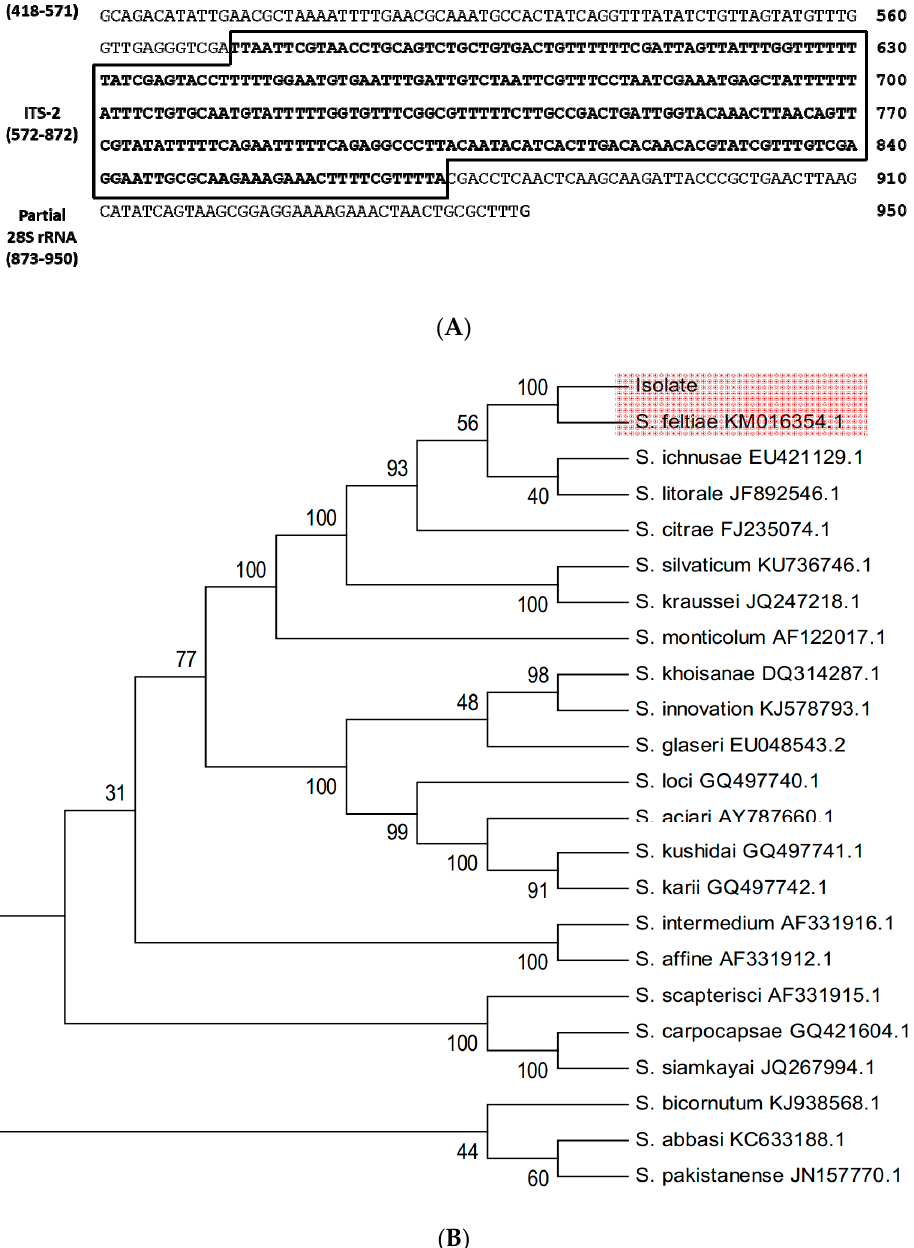
Figure 2. Molecular identification of S. feltiae isolate. ( A ) Sequence analysis of ITS / rRNA region of the nematode isolate. Two ITS regions are marked with boxes. The DNA sequence was deposited to GenBank with an accession number of MN093395.1. ( B ) Phylogenetic relationship of the nematode isolate with other Steinernema species based on ITS and rRNA sequences. The tree was constructed with the Neighbor-joining method using MEGA6.0. Bootstrapping values on branches were obtained with 1000 repetitions. GenBank accession numbers of ITS / rRNA sequence are followed by species